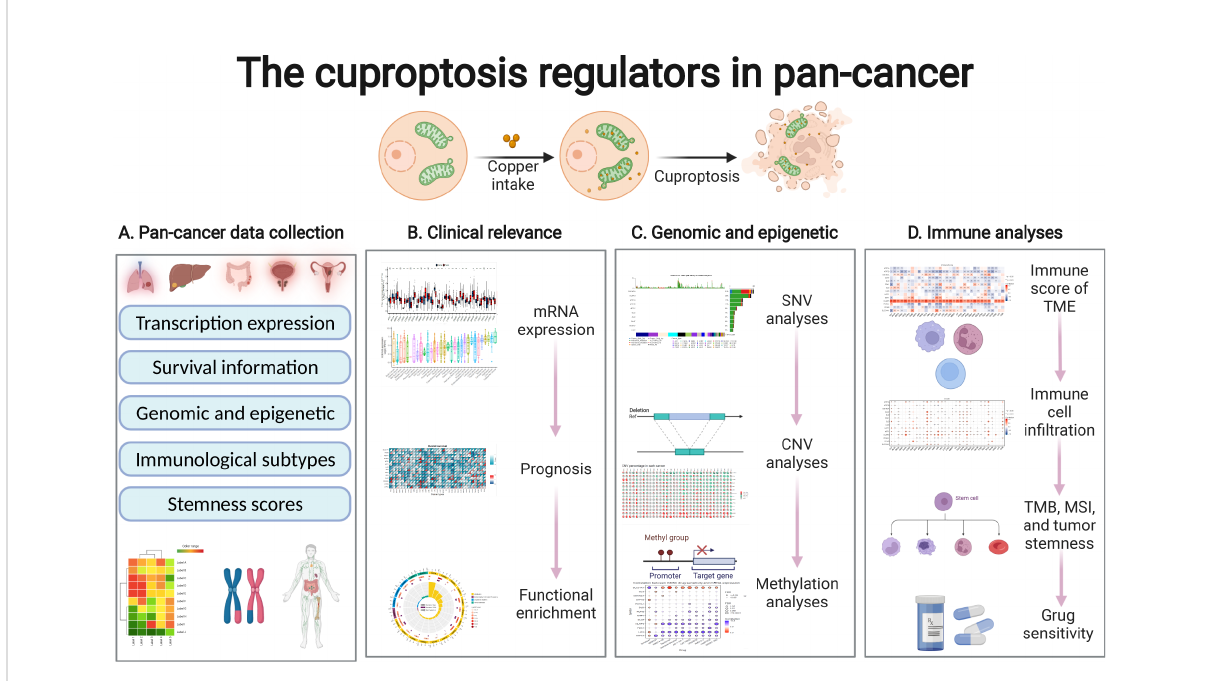
FIGURE 1 General overview of the